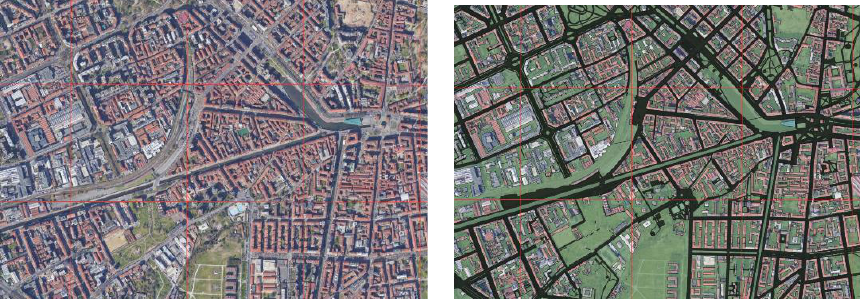
Figure 11. Left picture: Google satellite image of several squares; right picture: the layer of green areas reported in green.